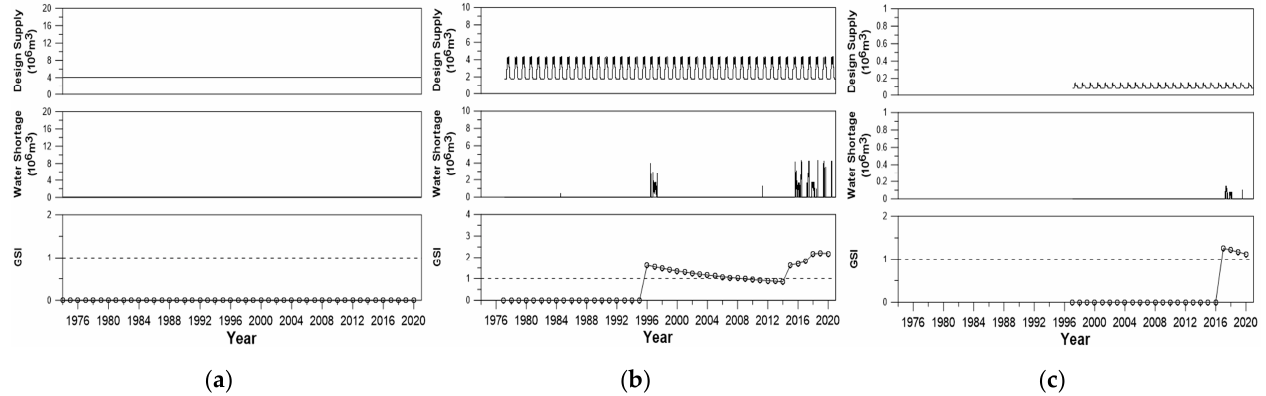
Figure 8. Estimation result of GSI for multipurpose dams selected for each type: ( a ) Soyanggang Dam (Type 1), ( b ) Imha Dam (Type 2), and ( c ) Daecheong Dam (Type 3).